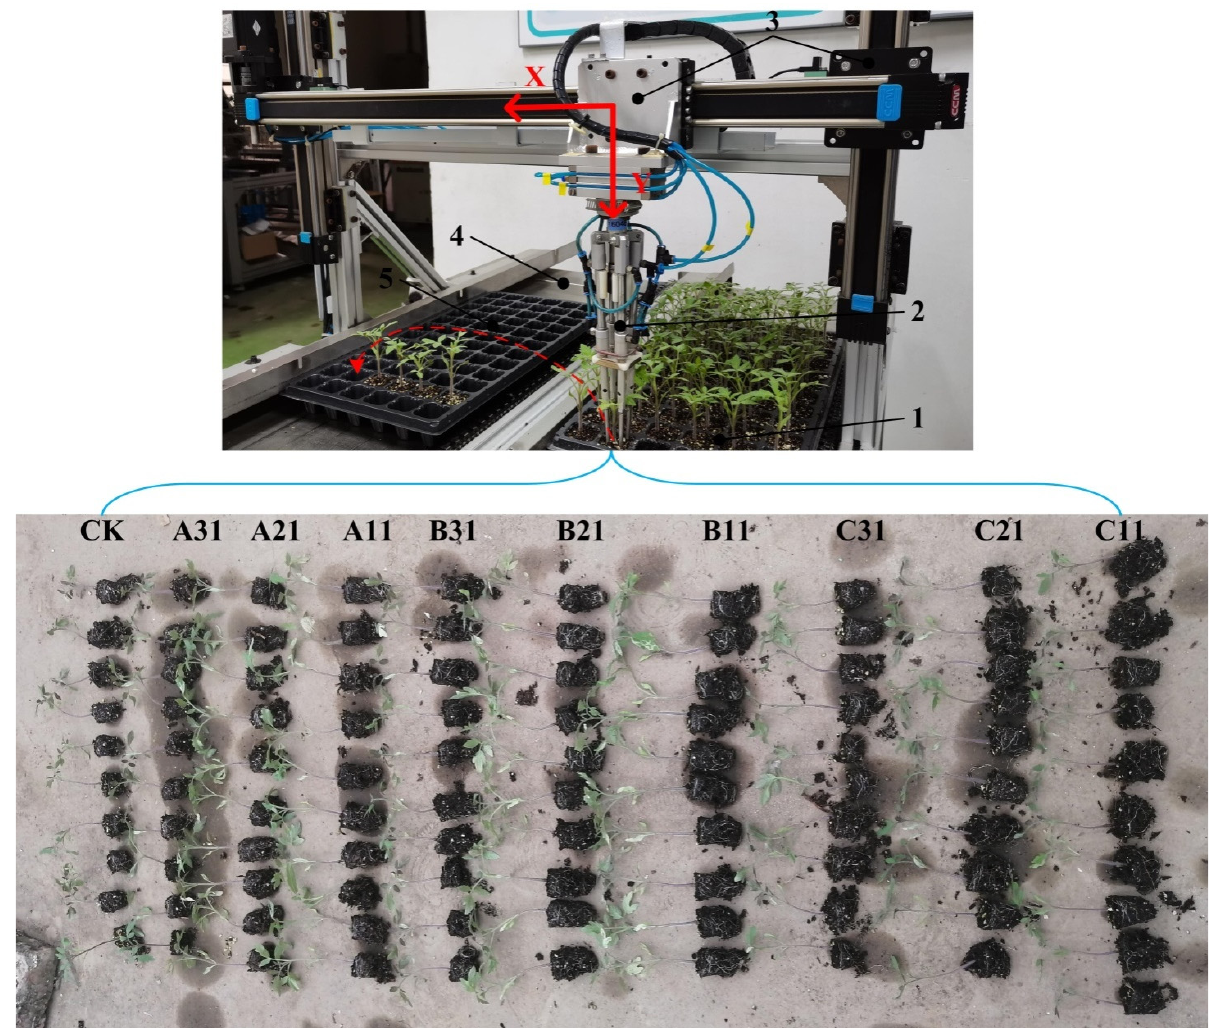
Figure 6. Failure morphology of various root lumps of tomato seedlings in automatic transplanting: (1) source tray; (2) seedling pick-up gripper; (3) Cartesian manipulator; (4) conveyor for seedling tray; (5) destination tray.